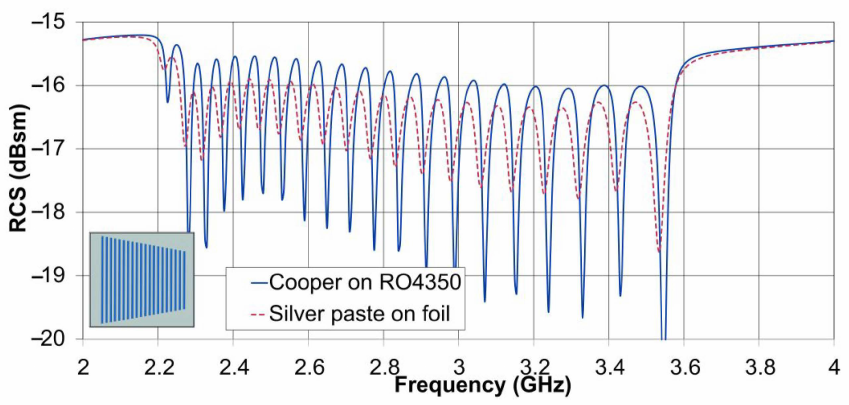
Figure 9. Simulated RCS of the array of detuned planar dipoles closely coupled to a rectangular metallic